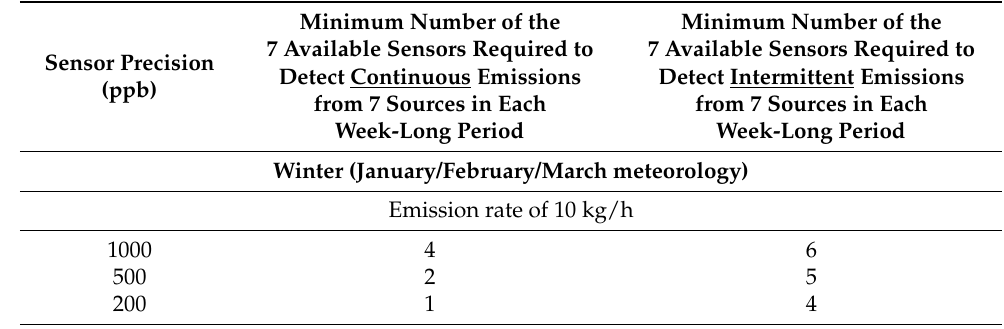
Table 4. Sensors required to detect continuous and intermittent emissions from each of the 7 emissions sites in the reduced density network, for the weeks representing winter, spring, summer, and fall meteorology (7 detections in each